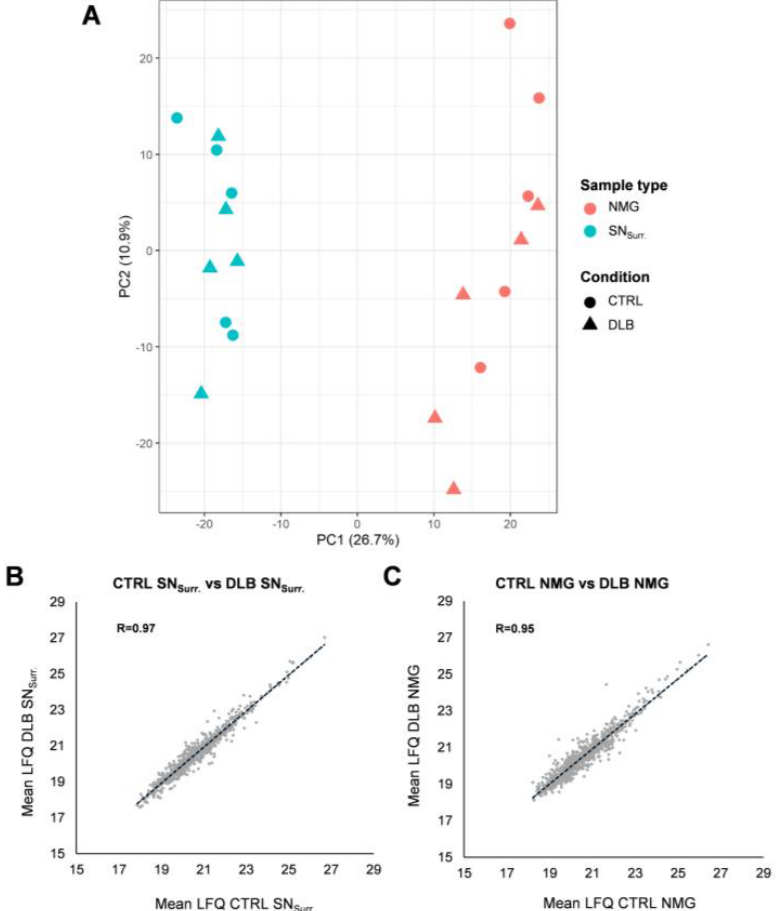
Figure 1. Statistical evaluation of our dataset. ( A ): Principal Component Analysis (PCA) of NMG and SN Surr. samples of DLB and CTRL cases shows a high similarity in the proteomic profile of NMGs and SN Surr. tissue between both conditions. In contrast, NMG and SN Surr. samples are highly separated on Principal Component 1. ( B ): Mean LFQ values for proteins in CTRL and DLB SN Surr. samples are highly comparable. The Pearson correlation coefficient of 0.97 supports this even further. ( C ): Comparison of mean LFQ values for proteins in CTRL and DLB NMGs reveals the high similarity between both conditions, which is also stressed by the Pearson correlation coefficient of 0.95.